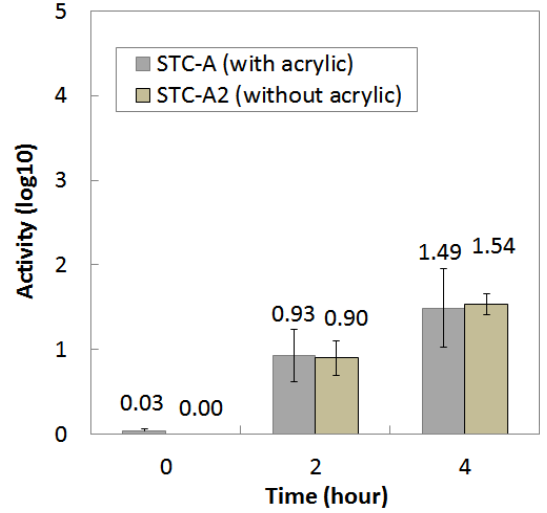
Figure 6. Antibacterial activity of STC-A and STC-A2 coatings under UV irradiation ( ≈ 2.5 W/m 2 ). Mean ± SE, n =